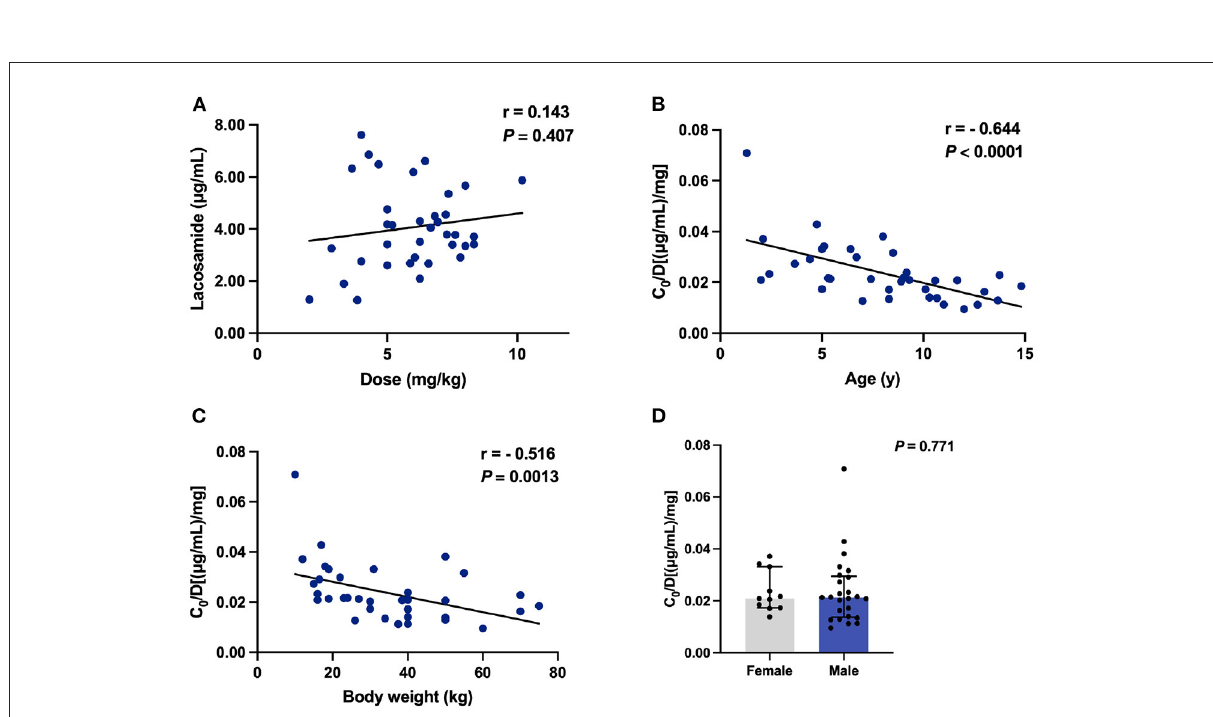
FIGURE4 The C 0 and C 0 /Dose ratio [( µ g/mL)/mg] of LCM in monotherapy ( n = 36). (A) Correlation between C 0 and dose (mg/kg); (B) Correlation between C 0 /Dose ratio and ages; (C) Correlation between C 0 /Dose ratio and BW; (D) A comparison of C 0 /Dose ratio in both